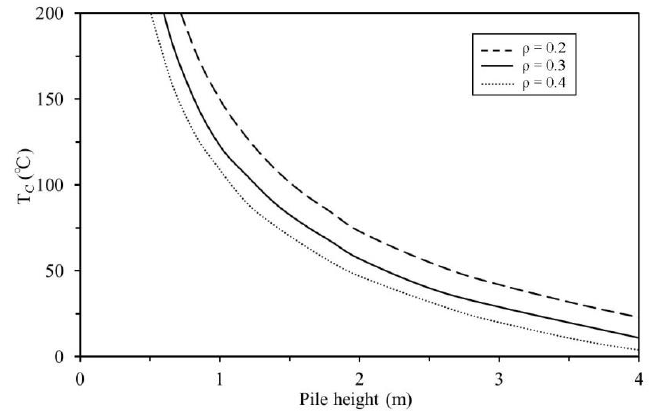
Figure 24. Frank-Kamenetskii results for fishmeal.